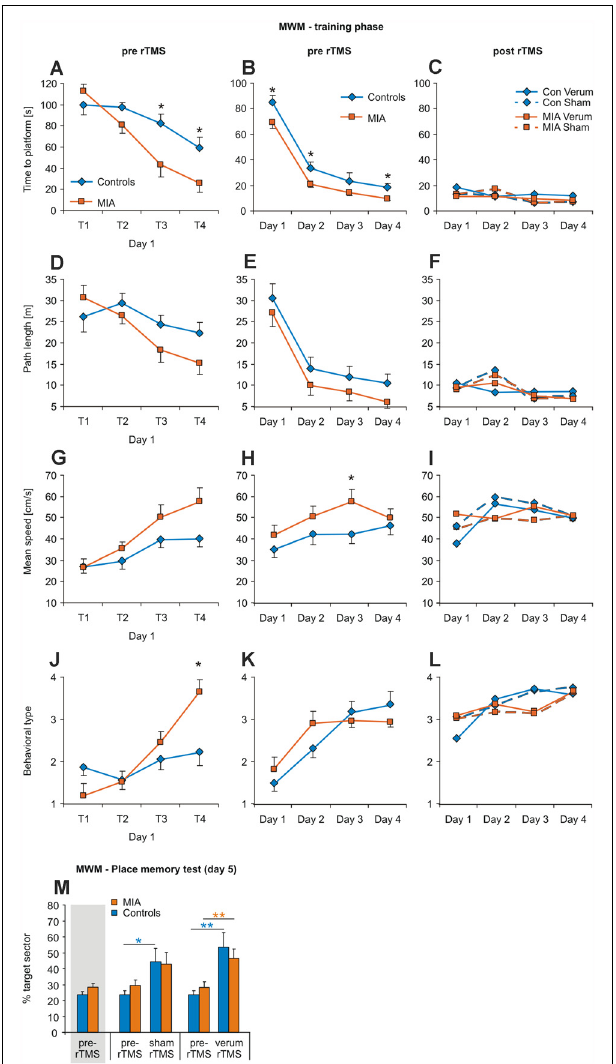
FIGURE 2 | iTBS applied to adult rats: effects on morris water maze (MWM). Measures of time to platform (A–C) , total path length (D–F) , mean swimming speed (G–I) and behavioral type (J–L) are separately shown for the four trials of the first training day (left column), for the means of days 1–4 (middle column) and for the days 1–4 when repeating MWM after sham or verum-iTBS (right column) with the platform position now shifted from north to south quadrant. (M) Results of the place memory test conducted on day 5 with the platform removed. Shown are percent time spent within the target quadrant during the first 30 s of testing both, for the test prior to iTBS and after either verum- or sham-iTBS. Colored asterisks: paired t -test [controls: blue, MIA: orange, in this case pre-iTBS data shown separately for sham and verum groups but pooled in case of the leftmost columns (gray shading)], black asterisks: t -test for independent samples (MIA vs. controls, 2-sided). * p < 0.05, ** p < 0.01. Data are shown as group means ± SEM. For clarity, SEMs are not shown for the post-iTBS samples. n /groups as in Figure 1 .